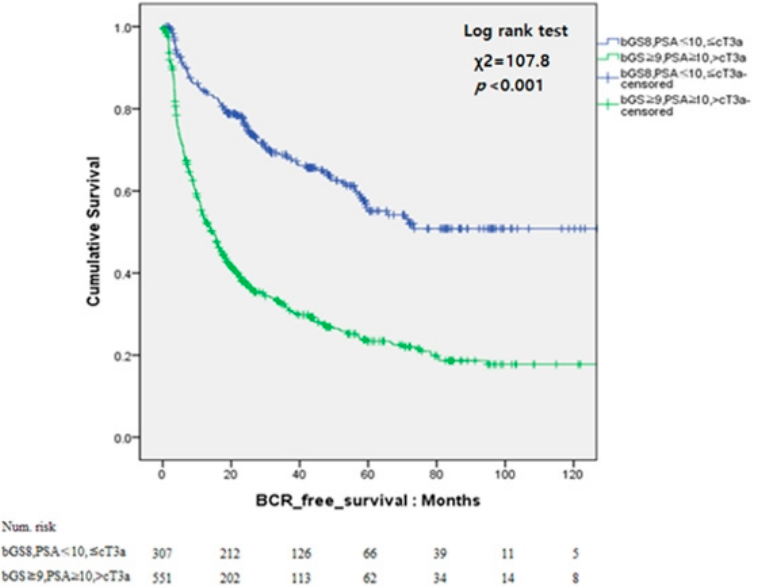
Figure 2. Kaplan–Meier curves for biochemical recurrence (BCR)-free survival according to bGS 8, PSA < 10 ng/mL, and ≤ cT3a.